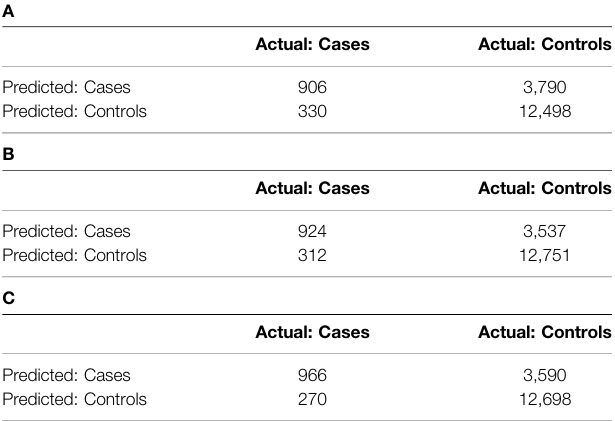
TABLE 2 | Confusion matrices for three machine-learning models.